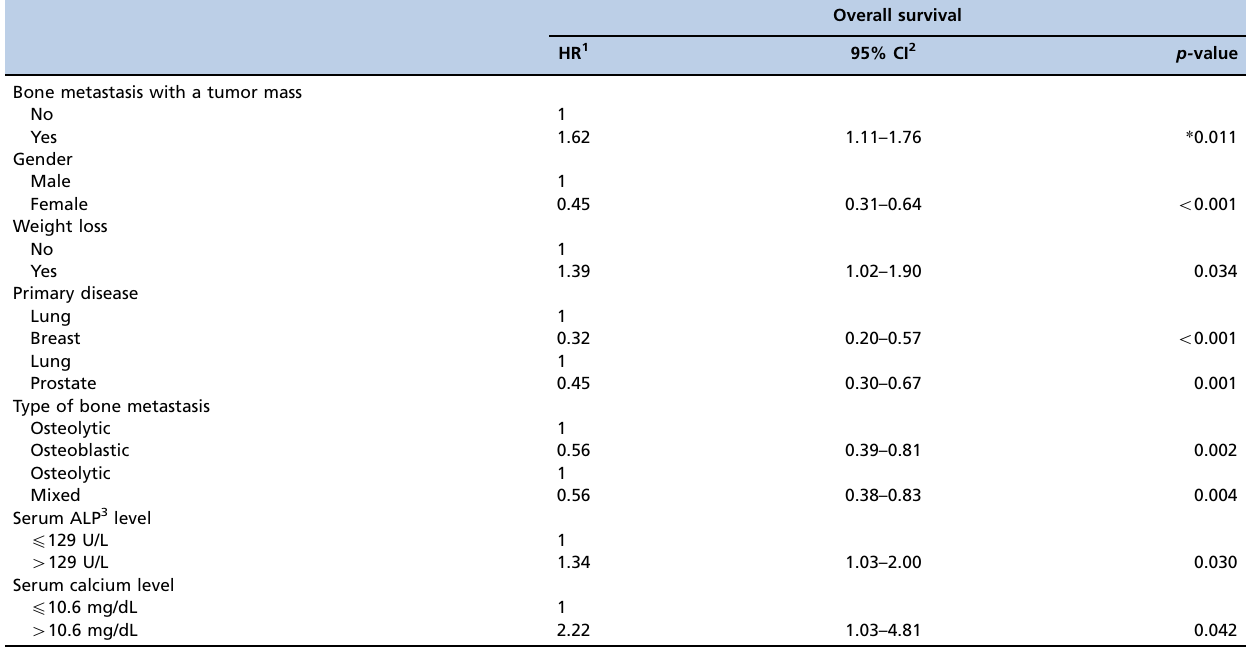
Table 3 - Independent prognostic factors affecting the duration of survival after the development of bone metastasis, as determined by multivariate